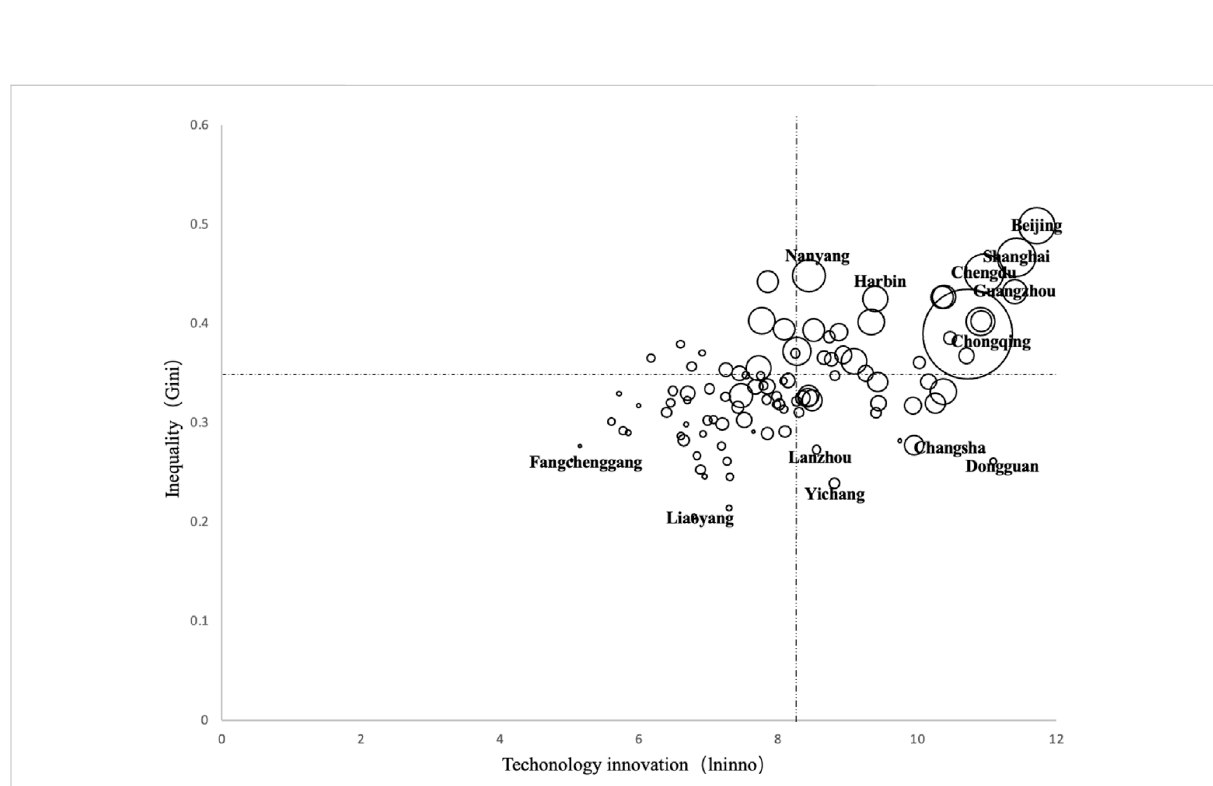
FIGURE 4 Gini coef fi cient, city size, and technological innovation